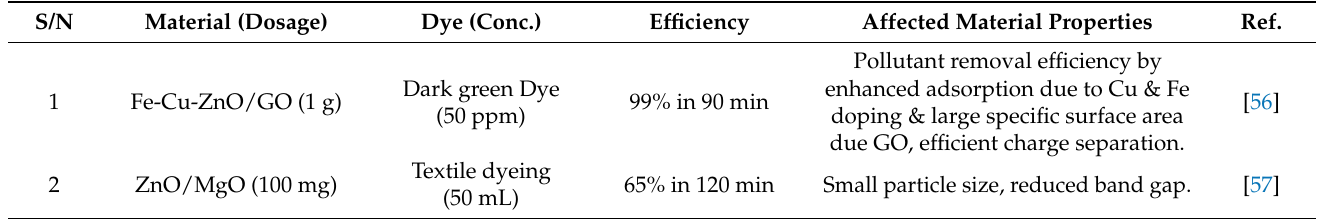
Table 7. Removal efficiency of ZnO nanoparticles in dyes polluted wastewater treatments. S/N Material (Dosage) Dye (Conc.) Efficiency Affected Material Properties Ref. Pollutant removal efficiency by Dark green Dye enhanced adsorption due to Cu & Fe 1 Fe-Cu-ZnO/GO (1 g) 99% in 90 min (50 ppm) doping & large specific surface area due GO, efficient charge separation. Textile dyeing 2 ZnO/MgO (100 mg) 65% in 120 min Small particle size, reduced band (50 mL)